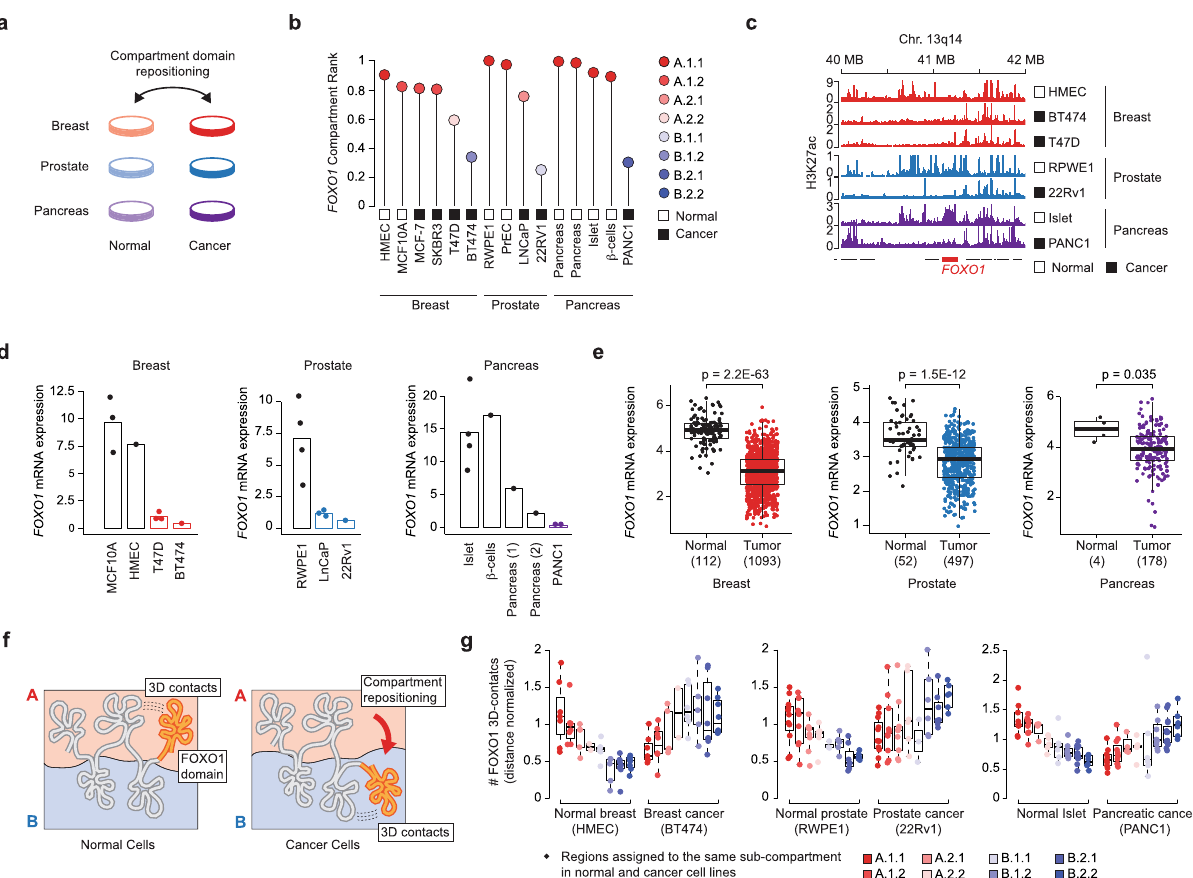
Fig. 4 Subcompartment repositioning between normal and cancer cell lines. a Schematic comparison of the comparison between normal and cancer cell lines from breast (red), prostate (blue), and pancreas (purple) tissues. b Compartment (color coded) and domain rank ( Y -axis) of the FOXO1 -containing domain in normal and cancer cells. c H3K27ac intensity at the FOXO1 locus for normal and cancer cell lines derived from breast (red), prostate (blue), and pancreatic (purple) tissues. d , e FOXO1 mRNA expression level (log2-transformed FPKM normalized RNA-seq reads) in either the cell lines with matching Hi-C data ( d ), or in normal and cancer samples pro fi led by The Cancer Genome Atlas (TCGA) ( e ). Each data point represents a replicate in ( d , n = 3, 1, 3, 1 – 4, 3, 1 – 4, 1, 1, 1, 2) and a sample in ( e , numbers of samples in brackets). f Schematic representation of interdomain interactions (dashed lines) between the FOXO1 -containing compartment domain (yellow) and regions that do not change compartment in normal and cancer cells (gray). The FOXO1 -domain is repositioned in cancer cells. g Distance normalized contact values between FOXO1 and regions that do not change compartment in the compared breast (left, n = 7, 7, 4, 2, 5, 5, 7, 8), prostate (center, n = 11, 10, 9, 6, 3, 6, 7, 6), and pancreatic (right, n = 9, 12, 4, 5, 6, 8, 16, 6) cell lines. The bounds of the box in the plot are fi rst quartile ( Q 1 ) and third quartile ( Q 3 ). The lower and upper whiskers are computed by extending the box bounds by 1.5* IQR , where IQR = Q 3 − Q 1